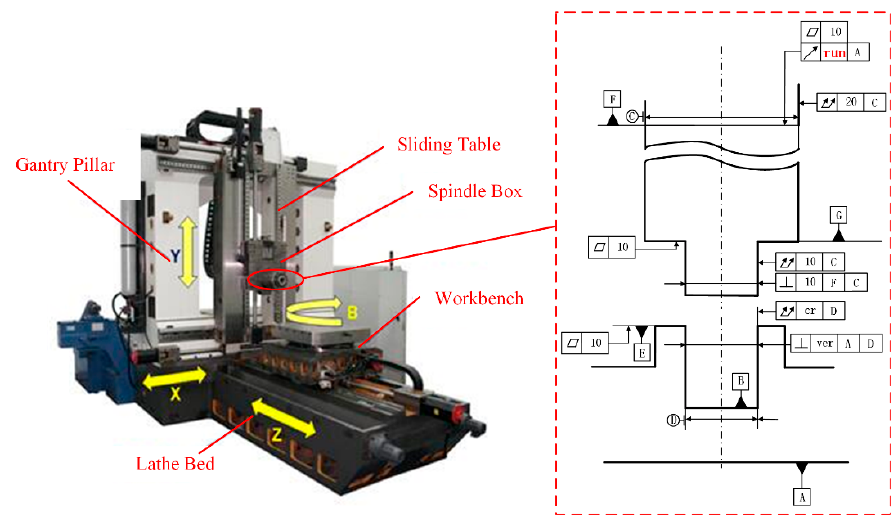
Figure 5. An assembly tolerance design example in designing the rotary feed system of a five-axis turning and milling complex center (VTM200F5).